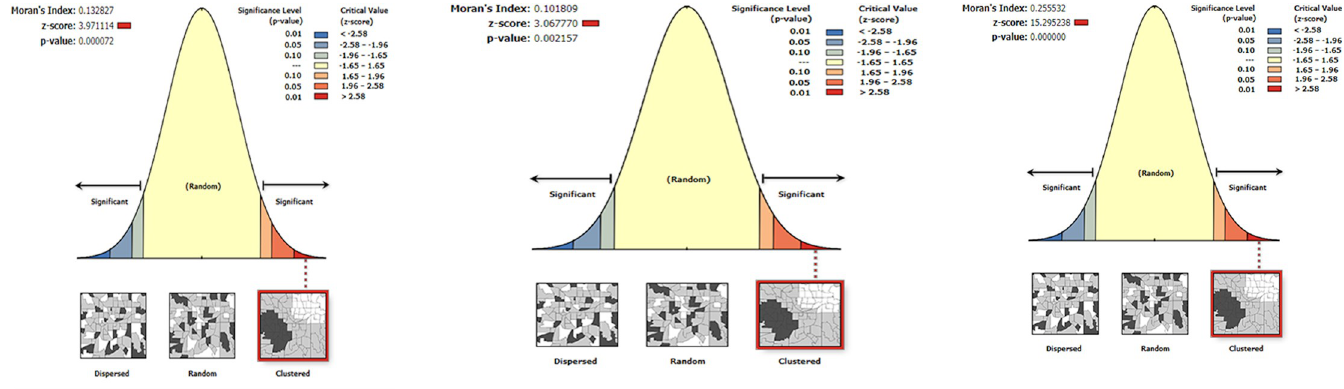
Fig 4. a-c: Spatial autocorrelation of anemia among lactating mothers in Ethiopia, 2005 (a), 2011 (b), 2016 (c) (Source: Shapefile from Central Statistical Agency, Ethiopia, 2013).